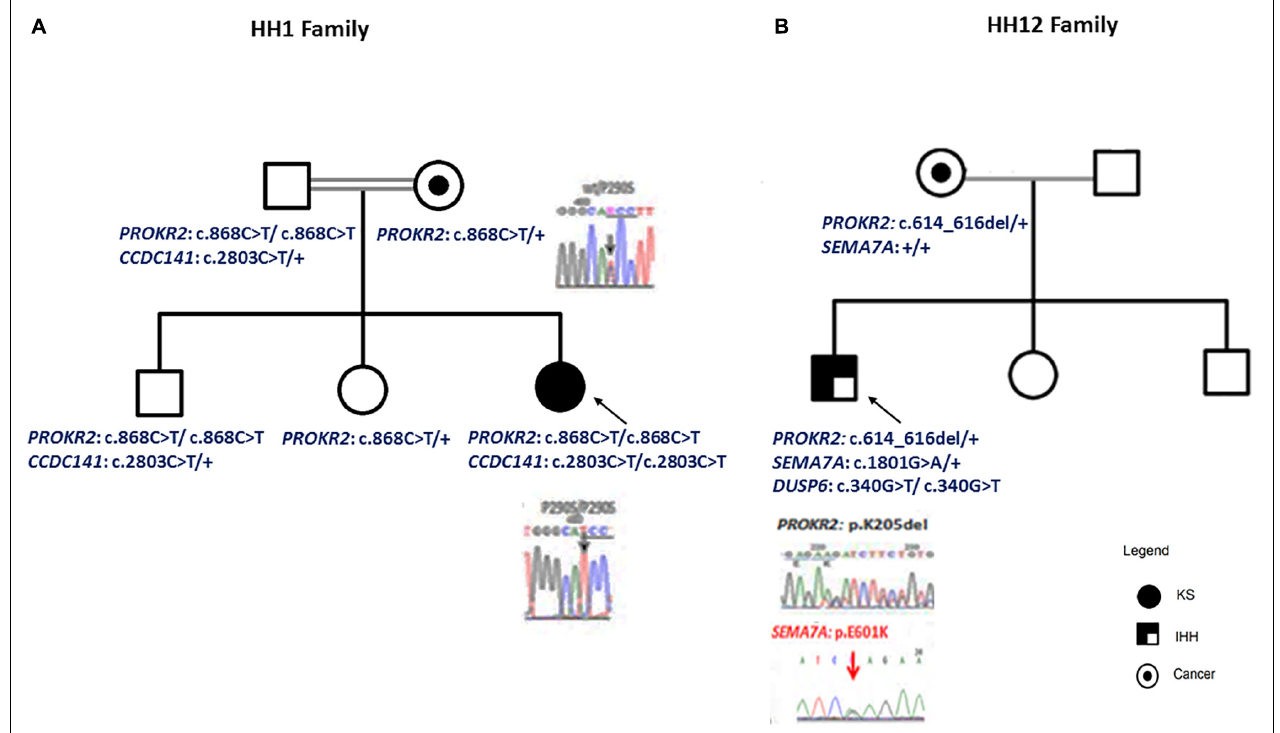
FIGURE 1 | Patient pedigrees and chromatograms of the confirmed mutations. The nuclear family of HH1 (A) and HH12 (B) patients. Chromatograms of the confirmed mutations are shown.